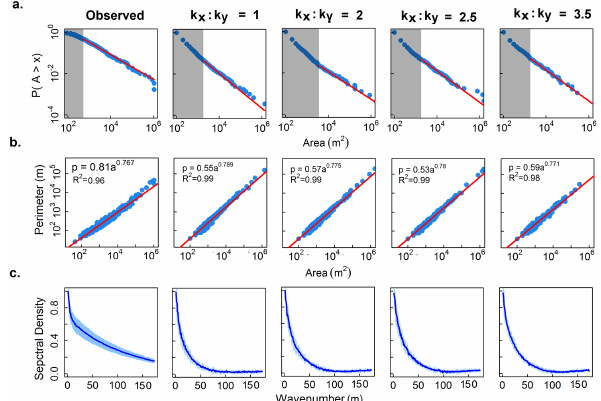
Figure 5. (a) Patch size distributions (blue dots) and power-law fits (red line) with cutoffs (gray shade), (b) perimeter–area relation- ships, and (c) r-spectrum plots with 95% confidence